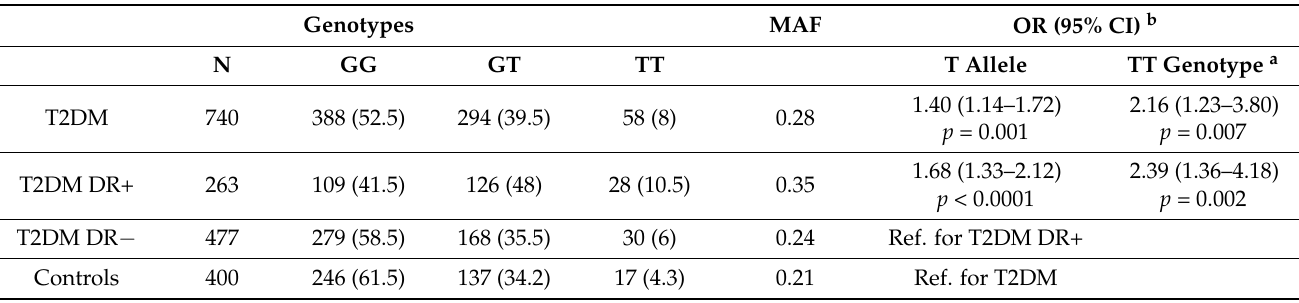
Table 2. Genotype and allele distribution of ARG1 rs2781666 polymorphism in patients with T2DM and healthy controls.